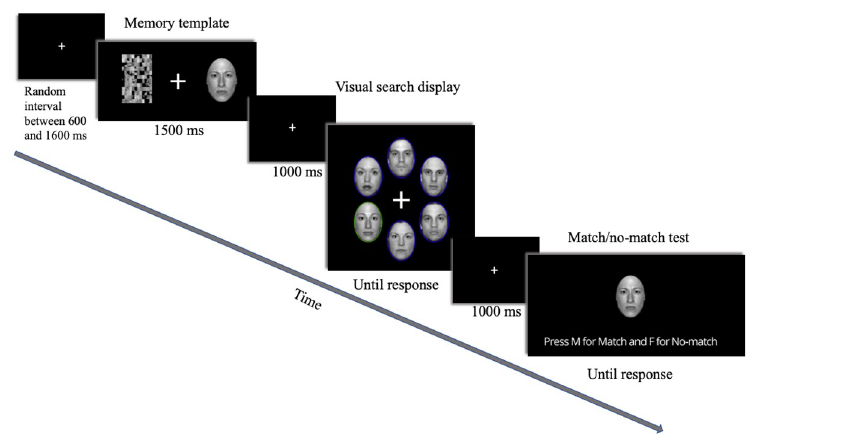
Fig 1. Dual task trial